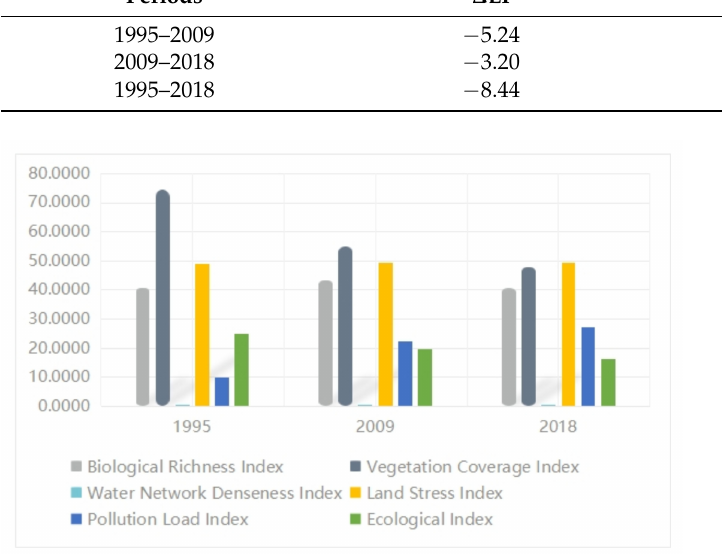
Figure 5. Changes in the eco-environment evaluation index in